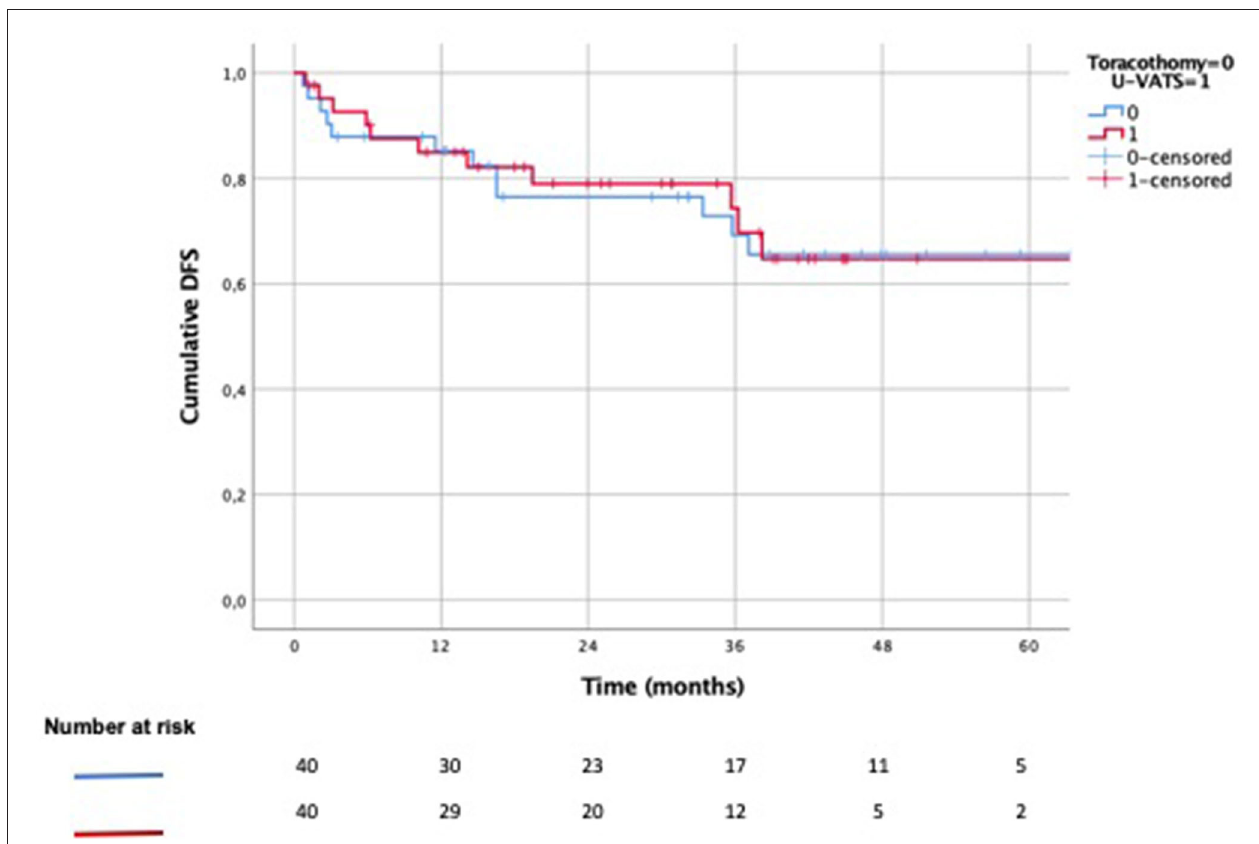
FIGURE 5 | Kaplan–Meier disease-free survival (DFS)